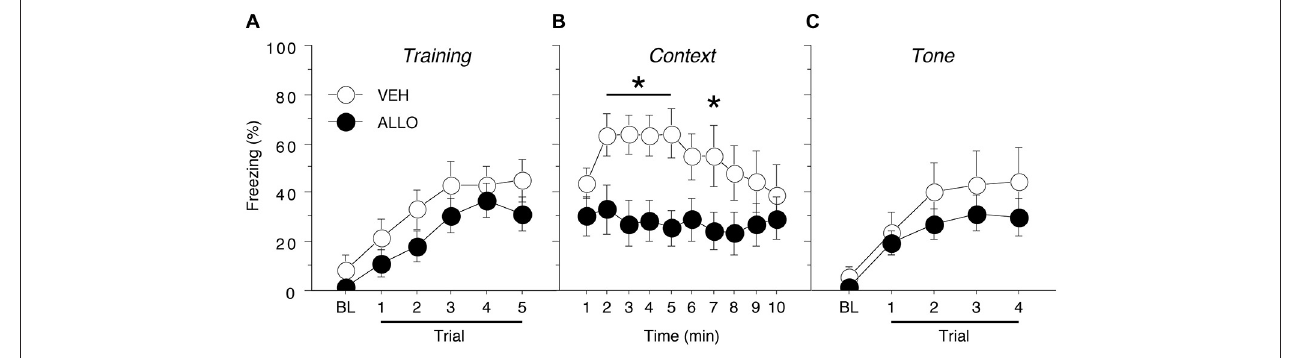
conditioning trial. (B) Mean percentage of freezing ( ± SEM) to context over 10 min 1 day after training. (C) Mean percentage of freezing ( ± SEM) to four auditory conditioned stimulus (CS) presentations in a novel context 2 days after training. Freezing was quantified before the first tone trial (baseline, BL) and during the 1-min period after each tone trial. * p < 0.05 ALLO vs.